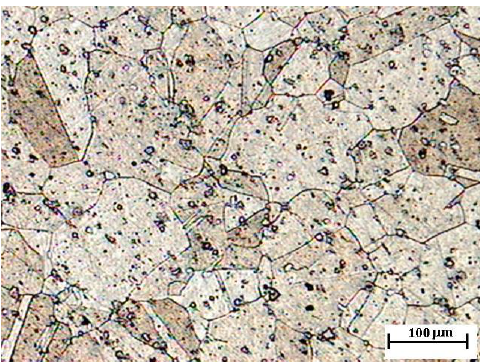
Figure 4. Optical micrograph of heat treated superalloy VAT 32. Magnification: 100×. Higher amount of precipitates is observed, in comparison with VAT 36 microstructure. Negligible twinned areas are observed.